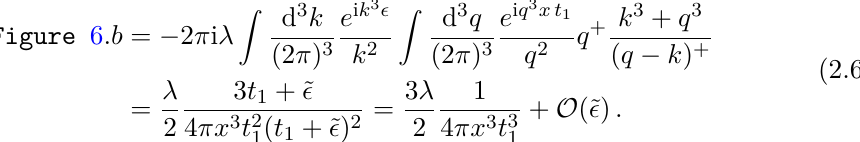
Figure 6 . The four diagrams that contribute to the modified propagator D ( − 1 ,α ) that in lightcone gauge, the diagram in which the gluon is absorbed by the straight Wilson line vanishes